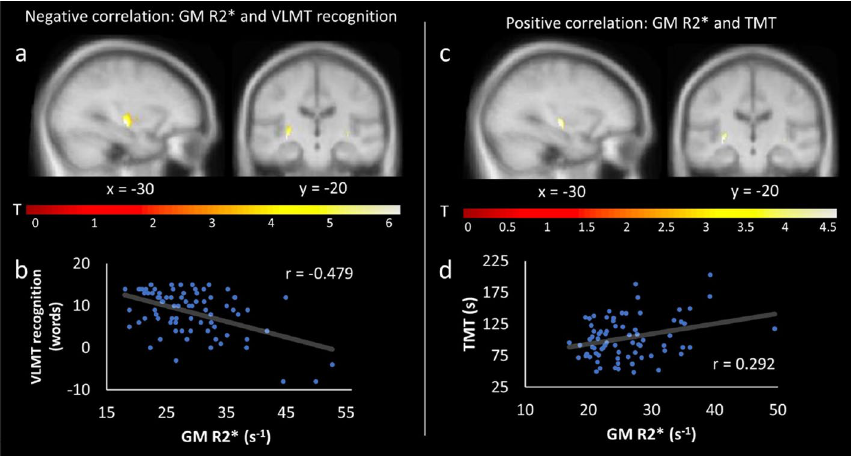
Figure 4. Relationship between cognitive performance and GM R2*. SPMs showing a significant negative relationship between GM R2* and VLMT recognition within the left and right putamen ( a ); a positive relationship between GM R2* and TMT within the left and right putamen ( c ). The corresponding correlation plots are shown in ( b , d ). In ( d ) three outliers were removed from the post hoc analysis (R2* values > 3 SD). For display purposes, SPMs were thresholded at p < 0.001, uncorrected, and superimposed on the mean T1-weighted image.